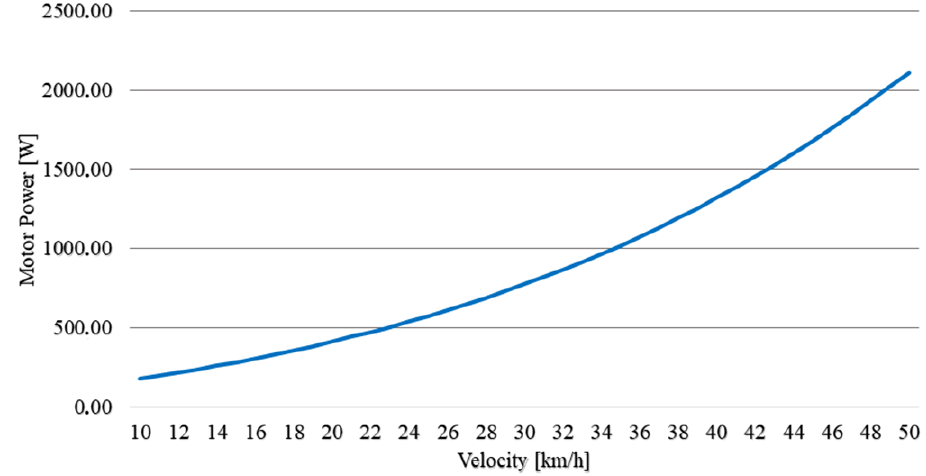
Figure 4. Relation between Motor Power and Velocity.